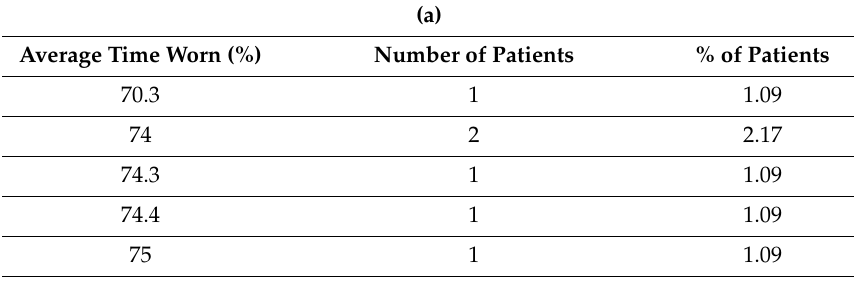
Table A4. ( a ) Patients who had a wear time ≥ 70% ( n = 75). ( b ) Di ff erences between patients with ≥ 70% wear time and < 70% wear time. Simple t-test and chi 2 tests were performed to determine a p value.